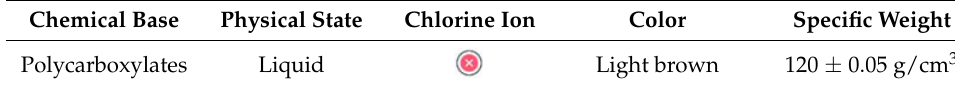
Table 3. Properties of superplasticizer.